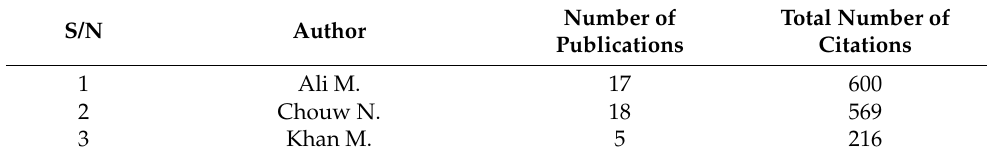
Table 3. Top 20 authors in the research of coconut-fiber-reinforced concrete up to